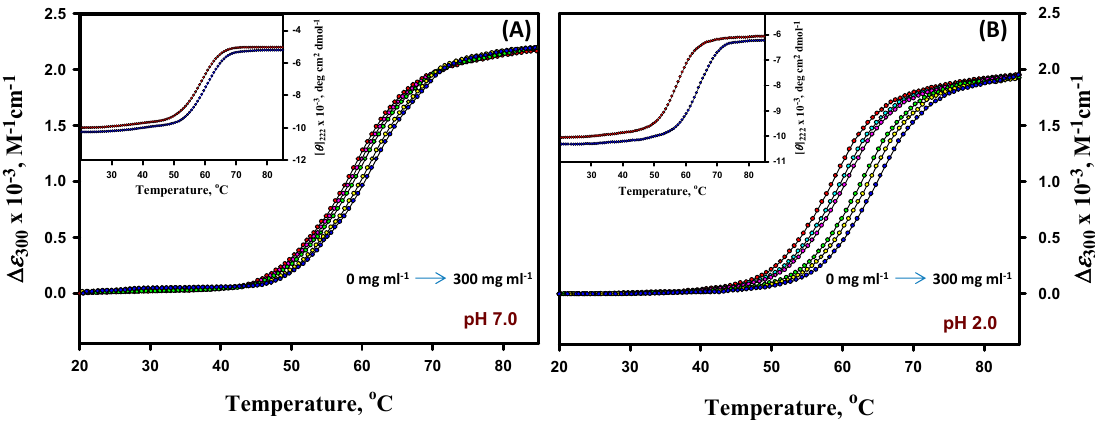
Figure 2. Thermal denaturation profiles of lysozyme in the absence and presence of different concentrations of dextran 40 at values pH 7.0 (panel A ) and 2.0 (panel B ). Different concentrations of dextran 40 are shown by different colors of circles, i.e., 0 mg mL − 1 (red), 100 mg mL − 1 (cyan), 150 mg mL − 1 (pink), 200 mg mL − 1 (green), 250 mg mL − 1 (yellow), and 300 mg mL − 1 (blue). For the sake of clarity, the curves at all concentrations are not shown. Insets in both the panels represent the thermal denaturation profiles of lysozyme measured by [ θ ] 222 in the absence (red circle) and presence of the highest concentration of dextran 40 (blue circle).